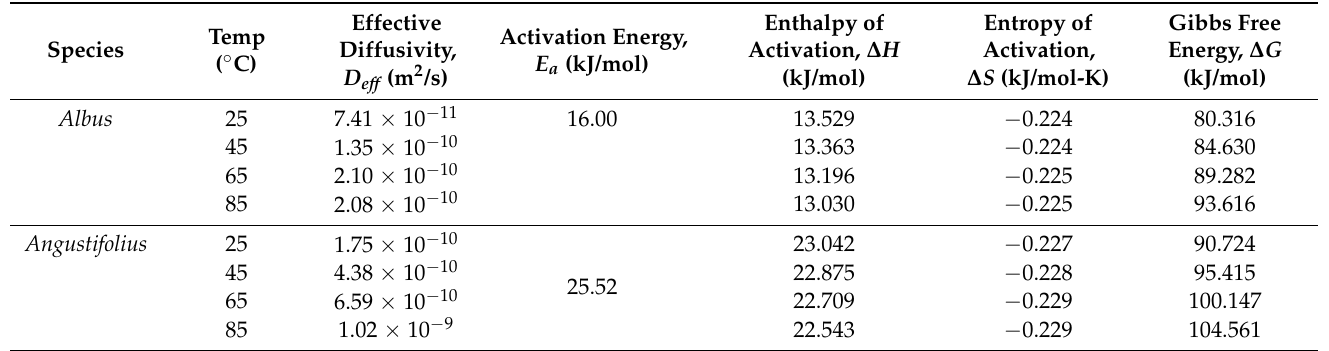
Table 2. Parameter estimates of the Fick model and thermodynamic